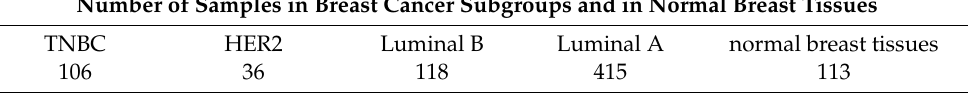
Table 2. TCGA cohort (transcriptome analysis): MEP50 mRNA expression in breast cancer subgroups and normal breast tissues (Figure